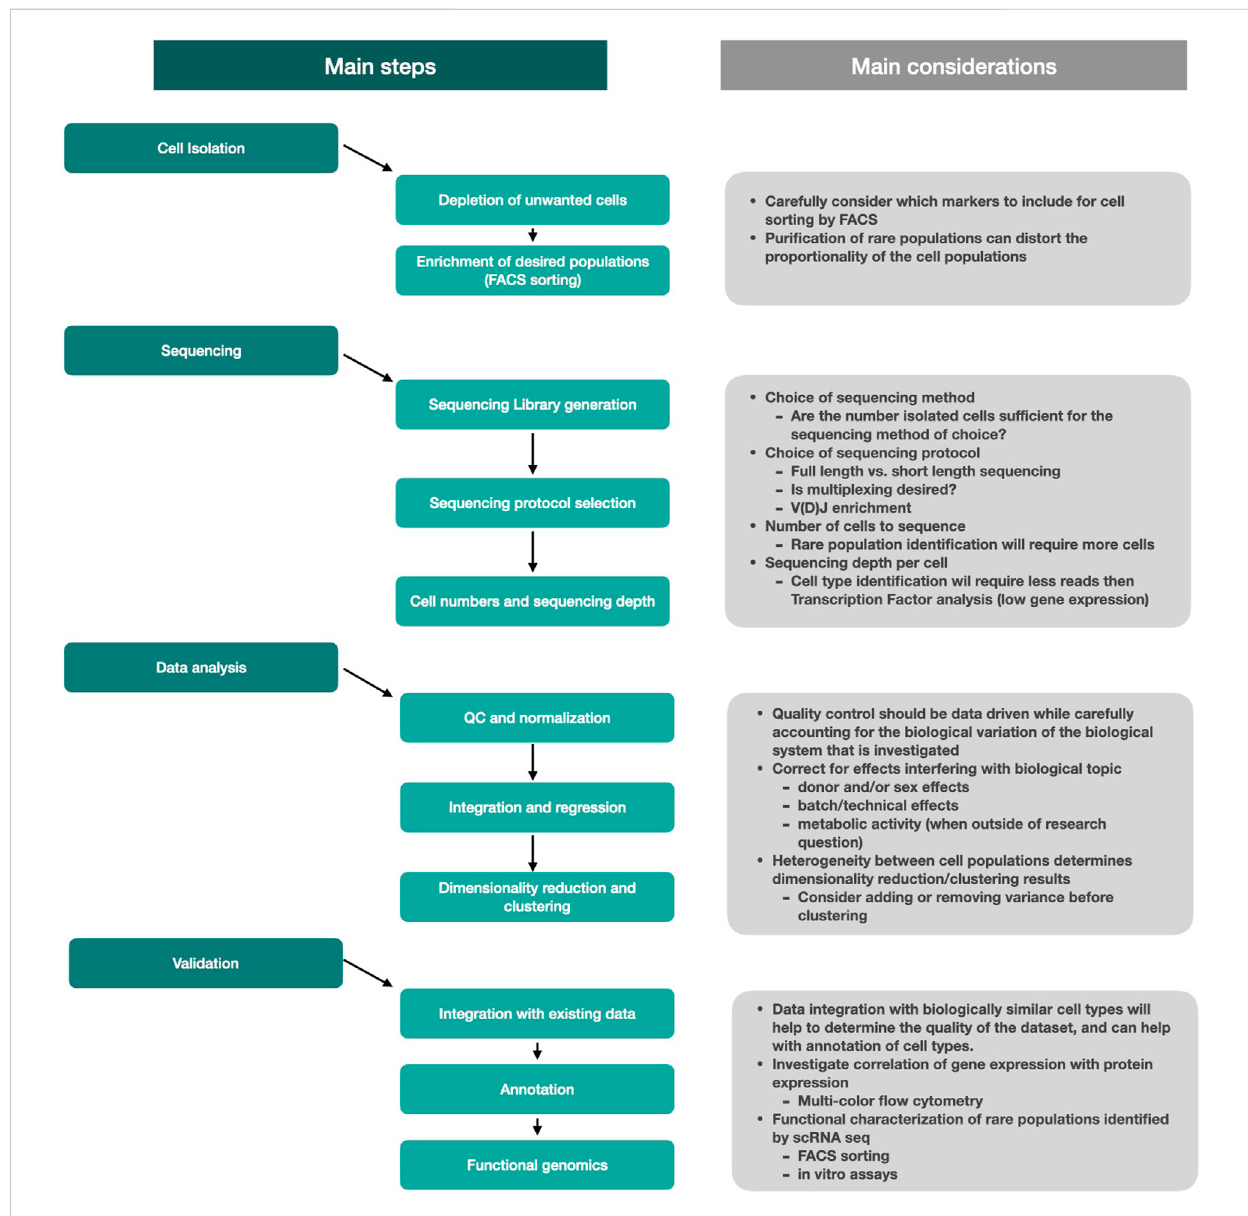
Schematic overview of the main steps and considerations used to perform studies on rare cells.